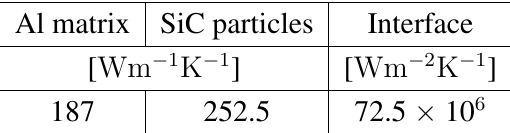
Table 1. Material properties [4].